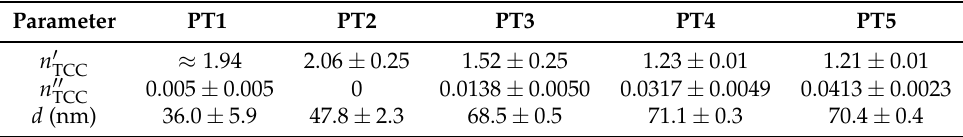
Table 5. Overview of refractive indices and layer thicknesses of the TCC coatings determined by using a three layer model described in detail in Section